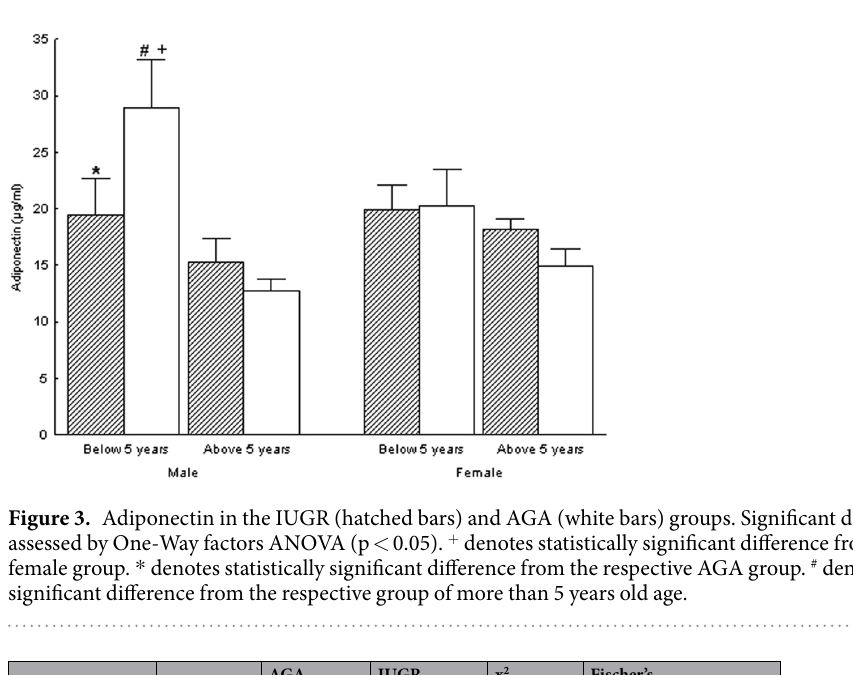
Figure 2. Leptin in the IUGR (hatched bars) and AGA (white bars) groups. Significant differences were assessed by One-Way factors ANOVA (p < 0.05). + denotes statistically significant difference from the respective female group. * denotes statistically significant difference from the respective AGA group. # denotes statistically significant difference from the respective group of more than 5 years old age.